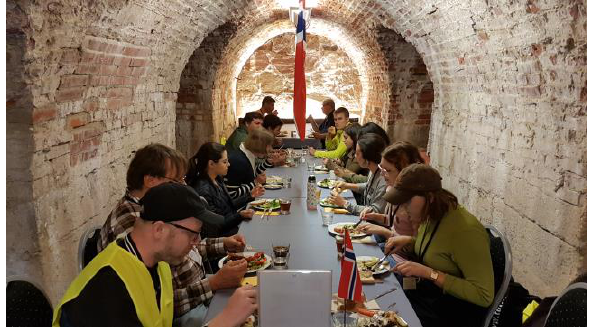
Figure 4. Working lunch inside the bastion at Linnoitusravintola Kamu!